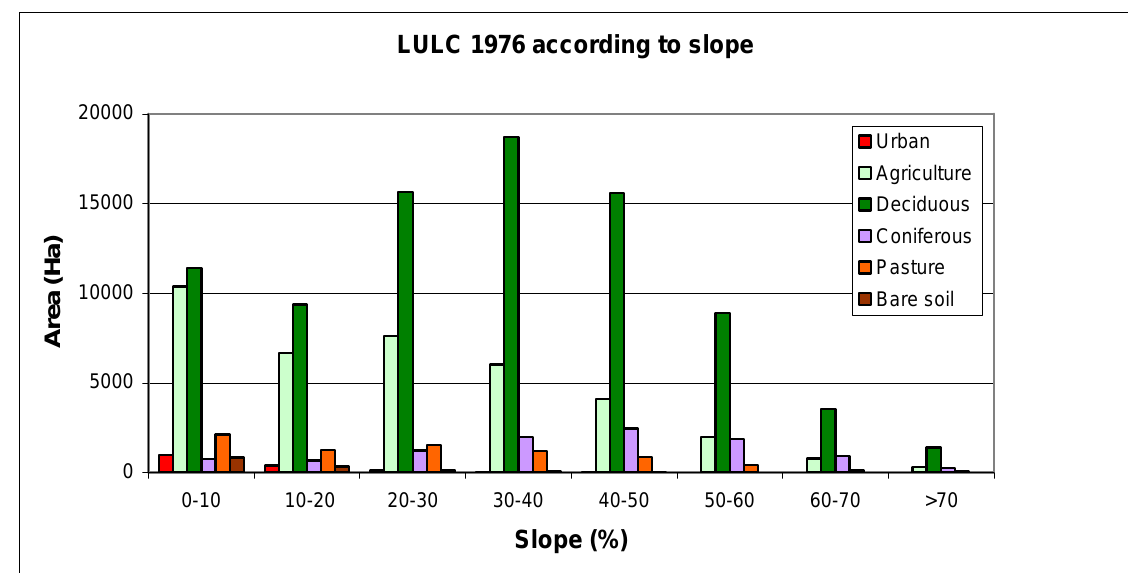
Figure 7. Land use\land cover and Slope in 1976 LULC 1976 according to